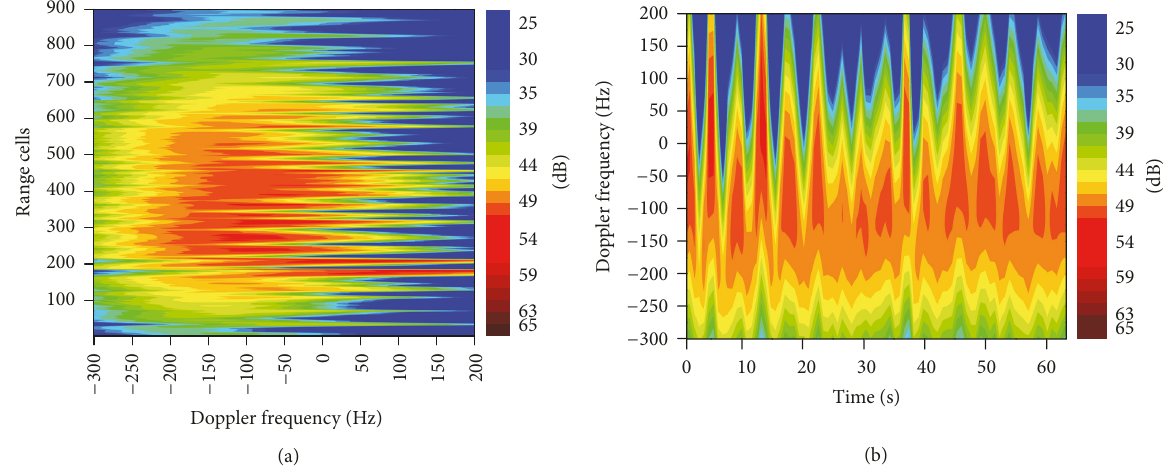
Figure 26: Examples of the simulated Doppler PSDs for the sum channel: the linear prediction coefficients for 𝑃 1𝑐 , 𝑃 2𝑐 , 𝑃 1𝑠 , and 𝑃 2𝑠 are {−55,102} , {−11, −132} , {−31,54} , and {20, 59} , respectively; 𝜎 Doppler maps, the 202nd range